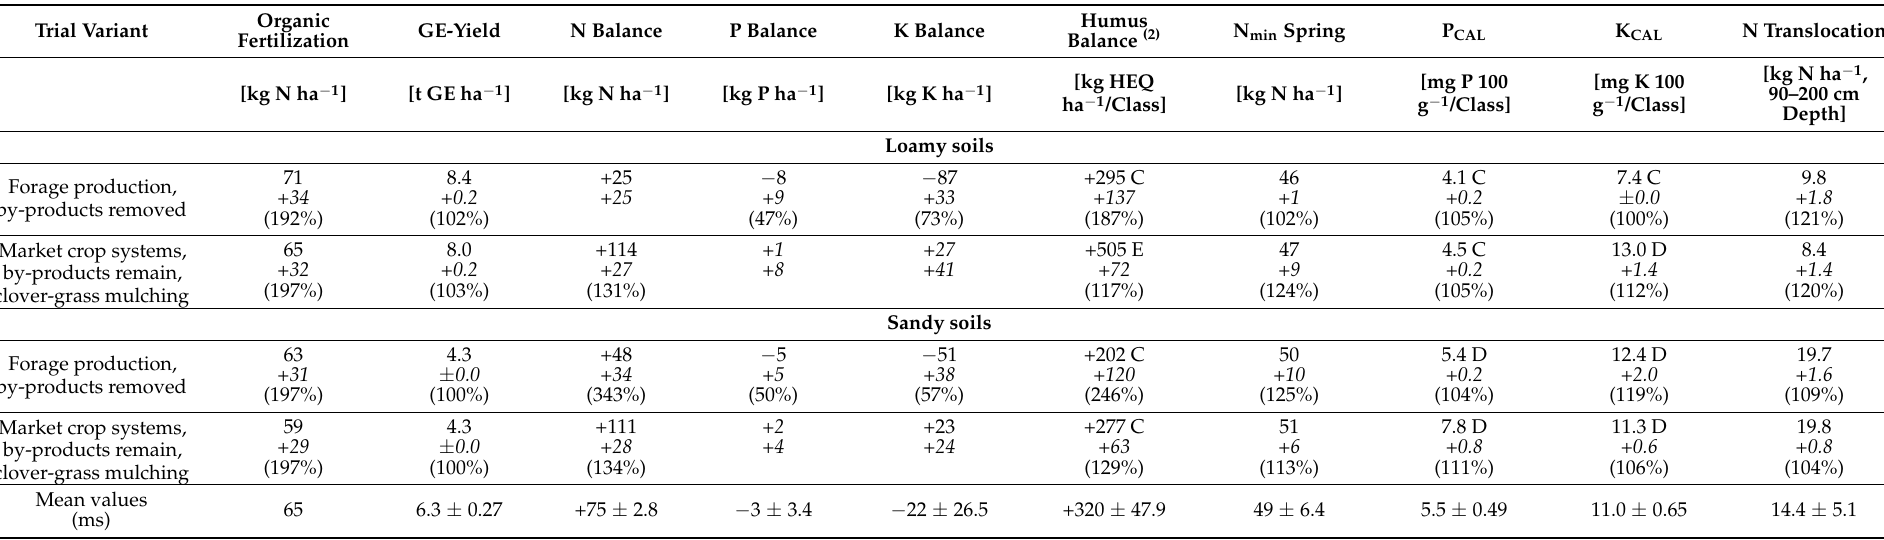
Table 7. Mean values, absolute (italics) and relative change (in parentheses) compared to an average intensity [=100%, see Table 2], and supply classes (1) of some important characteristics of yields, nutrient balances, and soil fertility of forage cropping and market crop systems of long-term field trials around 1.0 LU ha − 1 on loamy and sandy